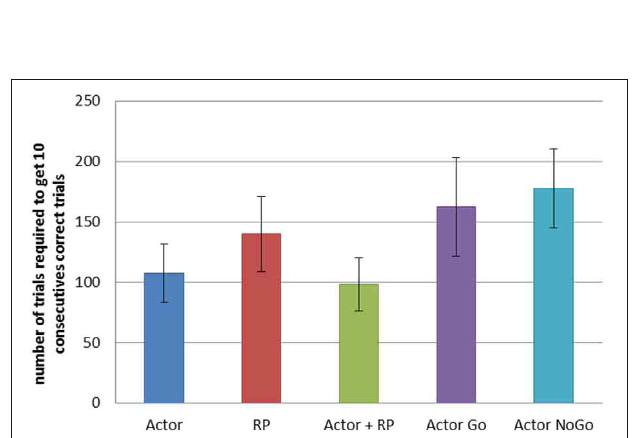
FIGURE 4 | Comparison of the learning speed of the different selection mechanisms on a simple learning task. The reward probability was set to 100%. The standard reward mapping was used in a network of 25 states and 5 actions. Results were averaged over 200 runs. Error bars represent standard deviation. All differences are significant at p < 0 . 001, except between Actor and Actor + RP ( p < 0 .